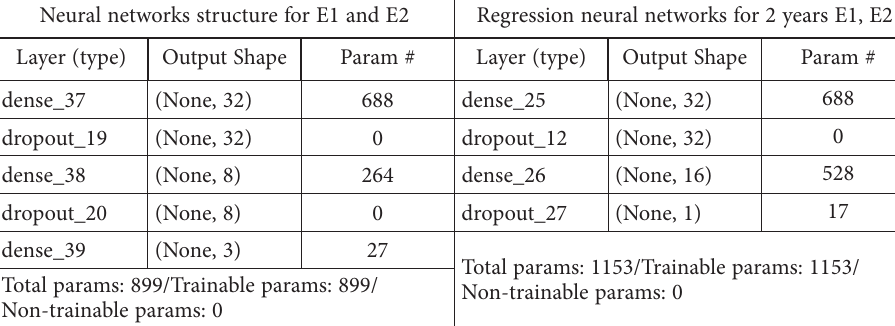
Table 6. NN structure for E1 and E2/Regression NN for 2 years E1, E2 (source: authors’ calculation) Neural networks structure for E1 and